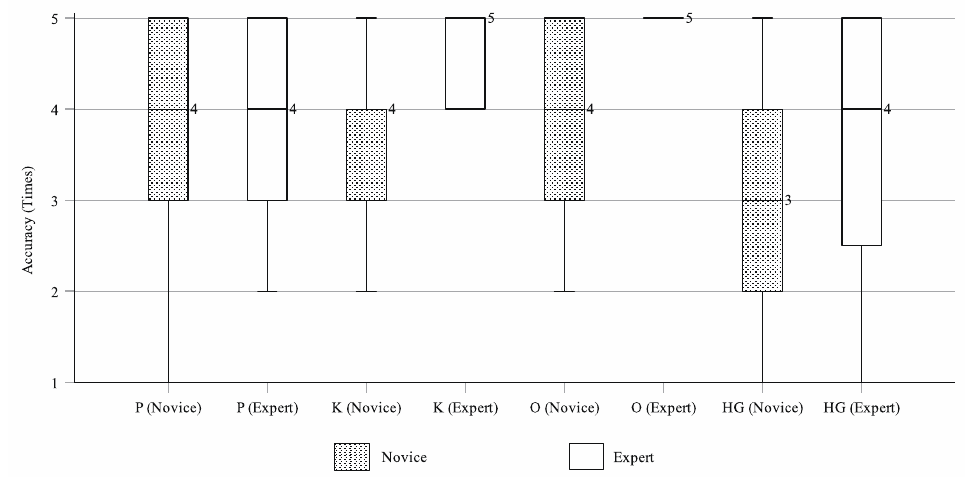
Figure 9. Distribution of unloading accuracy (number of times) by each approach to MCI.